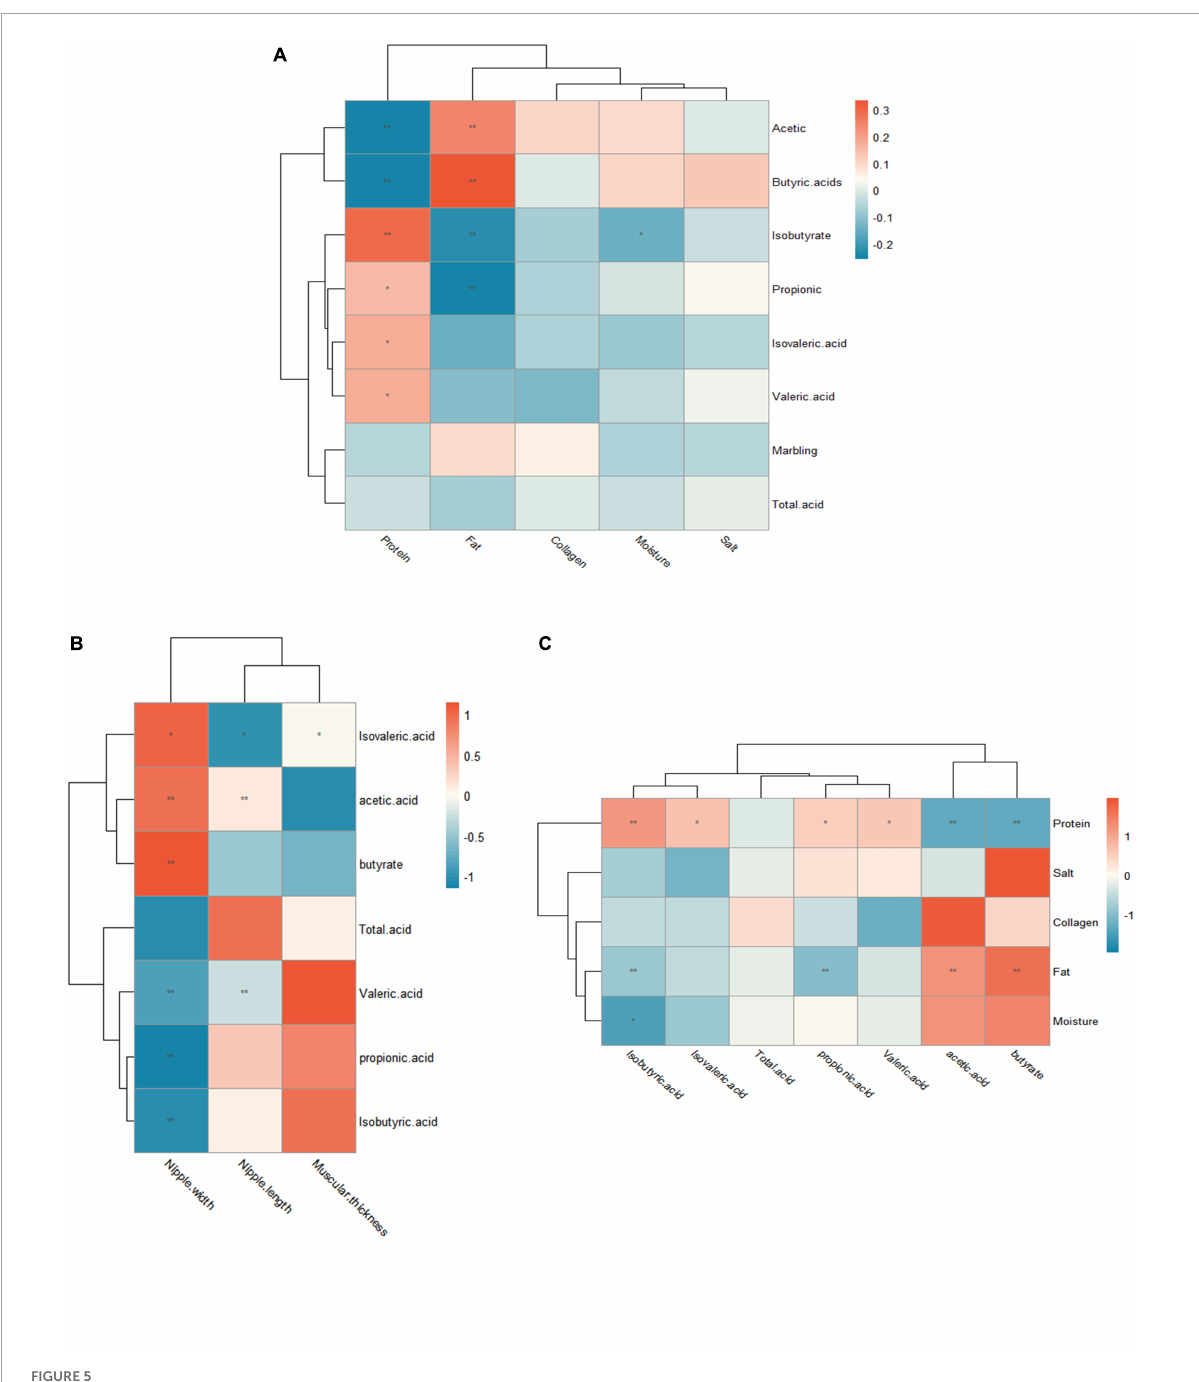
FIGURE5 Correlation analysis between significant biomarkers and marbling grade. (A) Heat map showing the Spearman’s correlation coefficients among significant biomarkers and marbling grade, VFA. (B) Heat map showing the Spearman’s correlation coefficients among muscle chemical composition and VFA. (C) Heat map showing the Spearman’s correlation coefficients between VFA and rumen epithelial